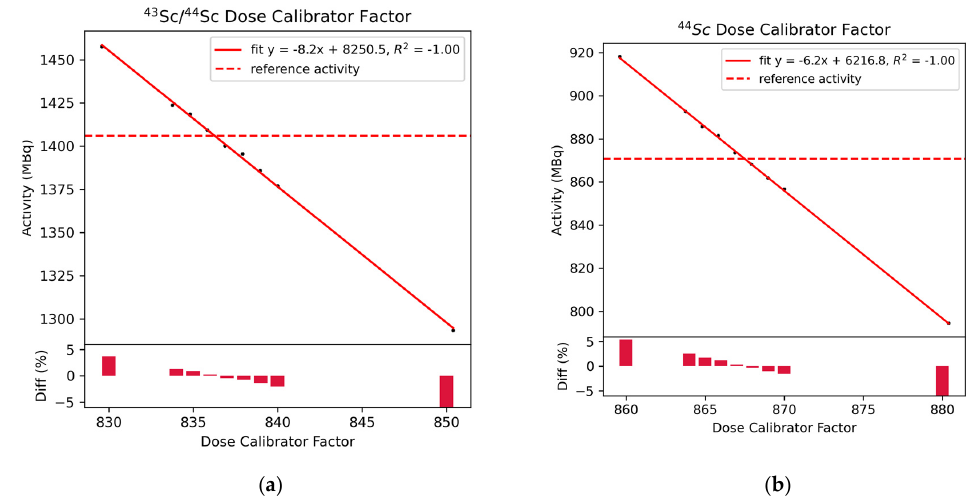
Figure 2. Results obtained using the linearity method for both the scandium-43/44 mixture and the radionuclidically pure scandium-44. ( a ) Measurements for the scandium-43/44 mixture across a range of calibrator factors; ( b ) Measurement for scandium-44.